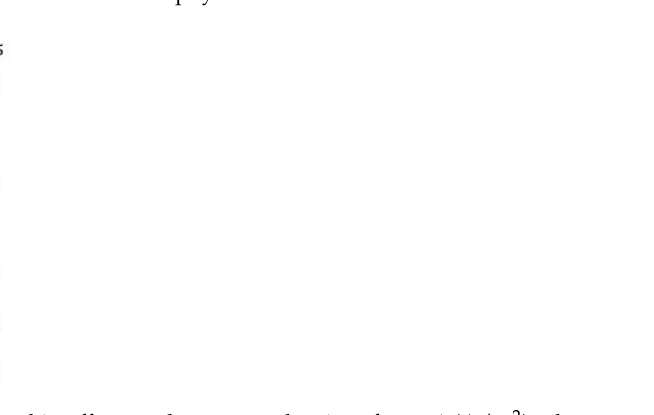
Figure 11. The mesh method in COMSOL Multiphysics.